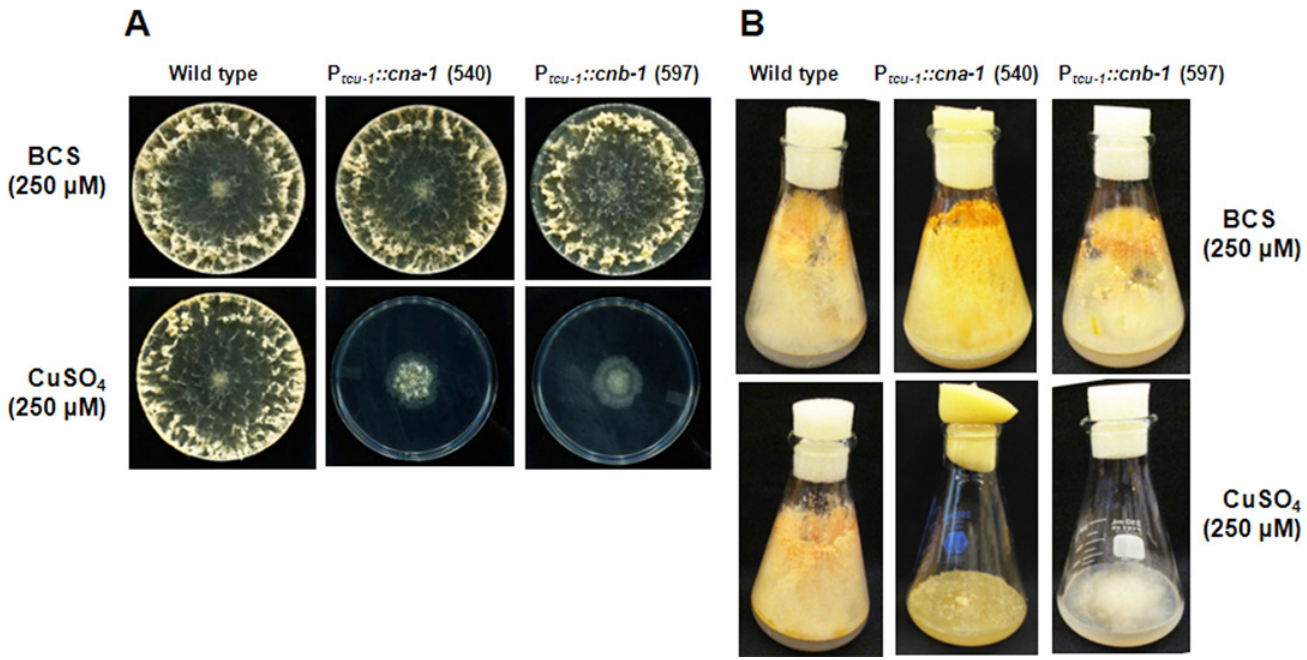
Fig 2. Effect of reduced expression of calcineurin on colony morphology. (A) Colony morphology. Wild type, Δ cna-1 :: hph; Δ pan-2 ::P tcu-1 :: cna-1 :: v5 :: gfp; mat a (540), and Δ cnb-1 :: hph; Δ pan-2 ::P tcu-1 :: cnb-1 :: v5 :: gfp; mat a (597) strains were cultured on VM plates supplemented with 250 μ M of BCS (upper panel) or CuSO 4 (lower panel). Strains were grown for one day at 30°C in the dark, followed by two days under constant light at room temperature and photographed using a Canon G10 camera. (B) Morphology of flask cultures. Cultures of wild type, Δ cna-1 :: hph; Δ pan-2 ::P tcu-1 :: cna-1 :: v5 :: gfp; mat a (540), and Δ cnb-1 :: hph; Δ pan-2 ::P tcu-1 :: cnb-1 :: v5 :: gfp; mat a (597) strains were grown in flasks containing VM agar medium supplemented with 250 μ M of BCS (upper panel) or CuSO 4 (lower panel). Strains were grown for three days at 30°C in dark and four days under light at room temperature and photographed using a Canon G10